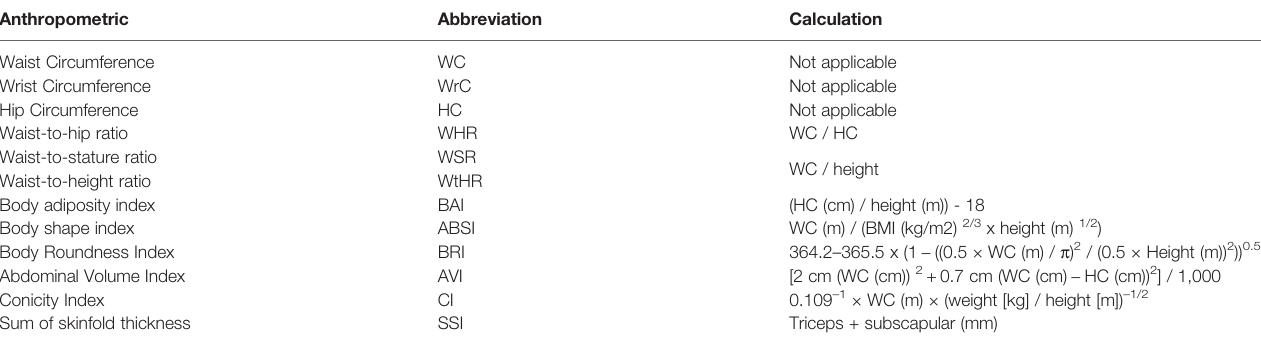
TABLE 1 | Anthropometric measurement examples with their abbreviations and derived equations.